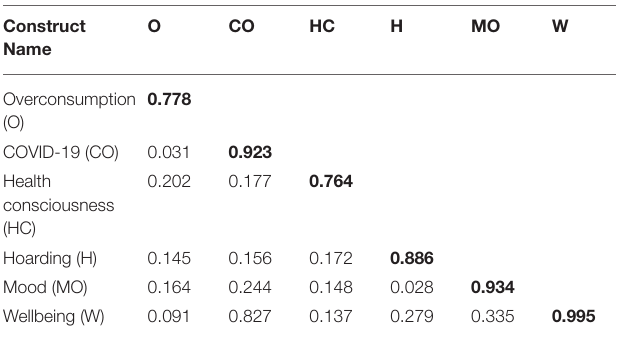
TABLE 3 | Discriminant